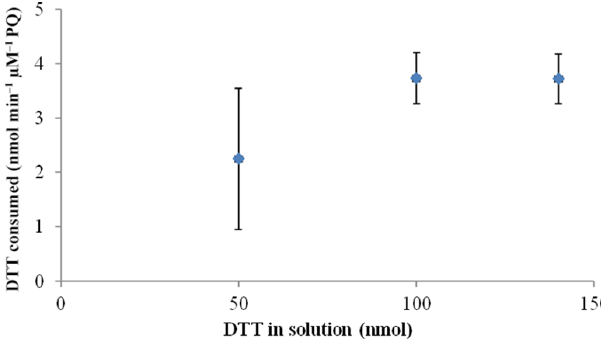
Figure 4. DTT consumption rate (nmolmin − 1 µM − 1 PQ) for dif- ferent initial DTT concentrations in solution (PQ concentrations of 0.25µM).